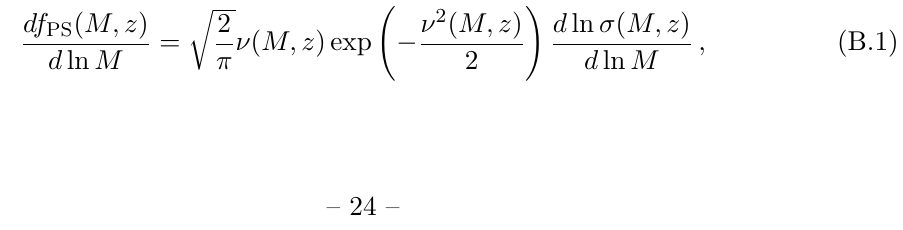
= 200 , ∆ t = 2 weeks , p